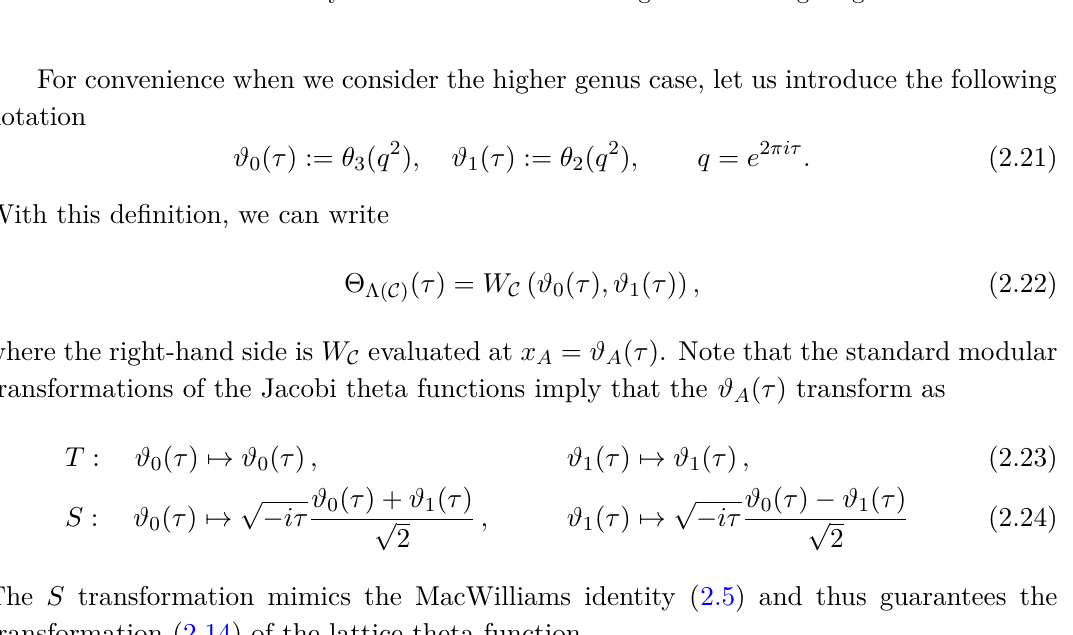
Table 2. Summary of the differences between genus 1 and higher